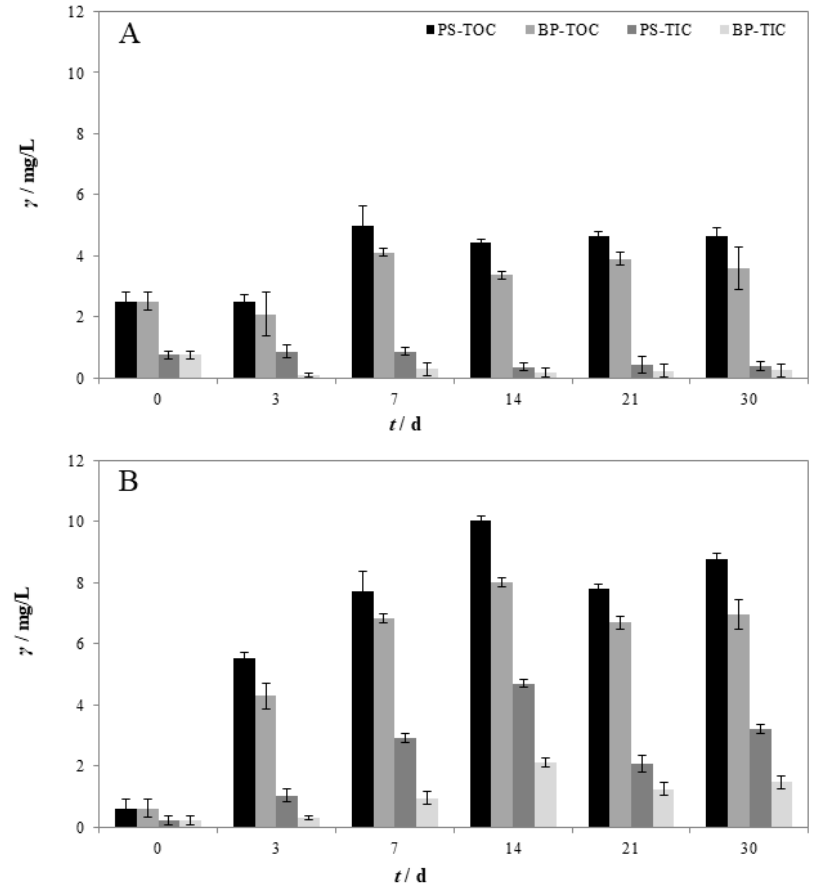
Figure 3. Changes in concentration ( γ ) of total organic carbon (TOC) and total inorganic carbon (TIC) for blank (BP) and sample (MP-PS) during 30 days of exposure to: ( A ) Bacillus cereus in experiment M1-24 and ( B ) Pseudomonas alcaligenes in experiment M2-23.